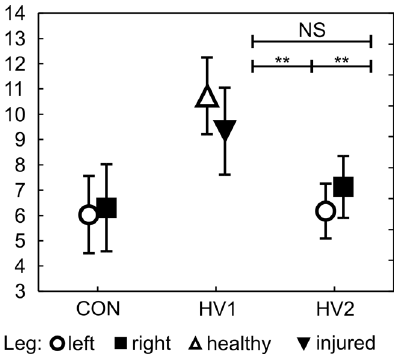
Fig.12 Minimum knee flexion (in deg) at terminal stance